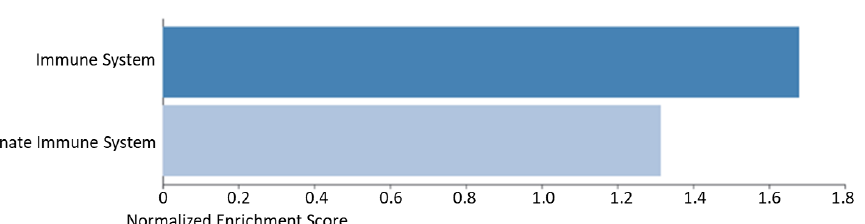
Figure 6. Gene-set enrichment analysis with the significant differentially expressed proteins after 6-